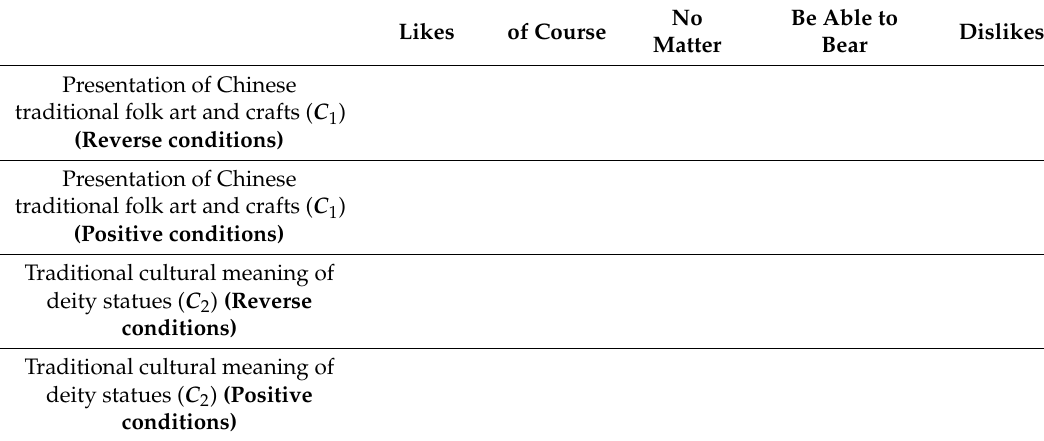
Table A1. Kano Model